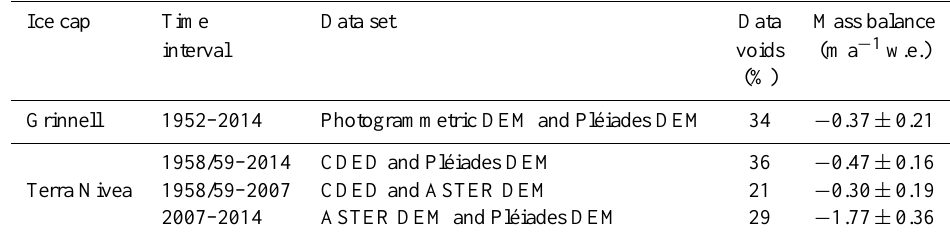
Table 2. Historical and recent glacier-wide mass balances for both ice caps.